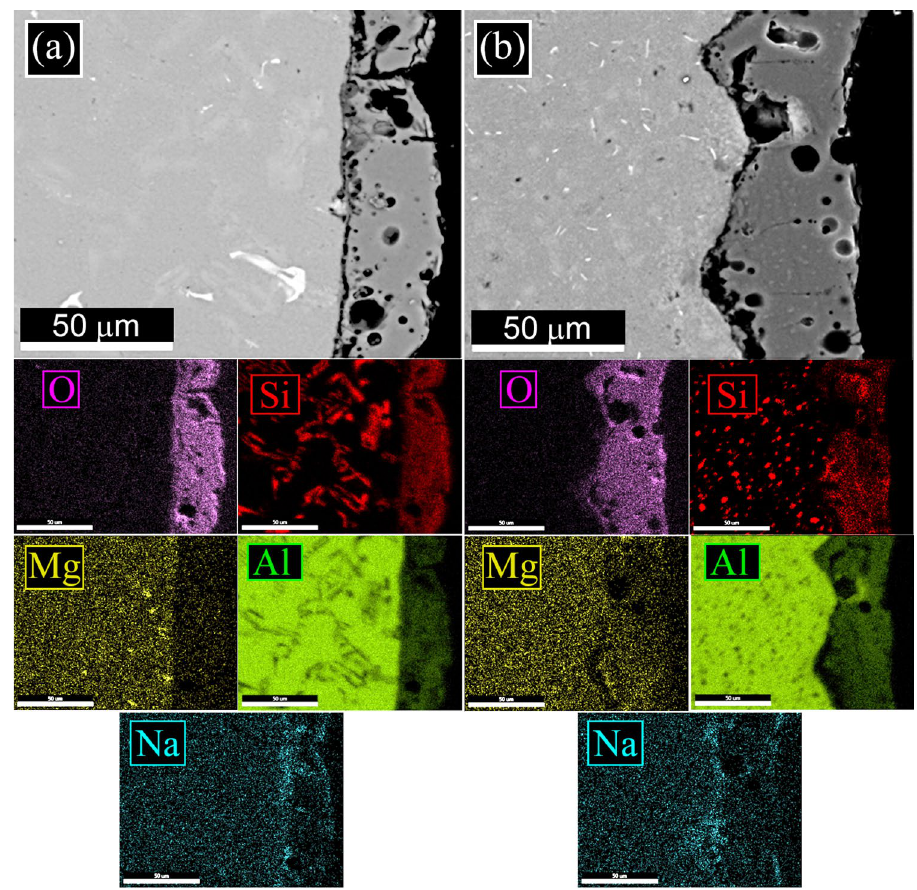
Figure 11. SEM–EDS elemental mapping of the cross-sections of the samples after PEO treatment: cast sample ( a ) and solution treated sample ( b ).